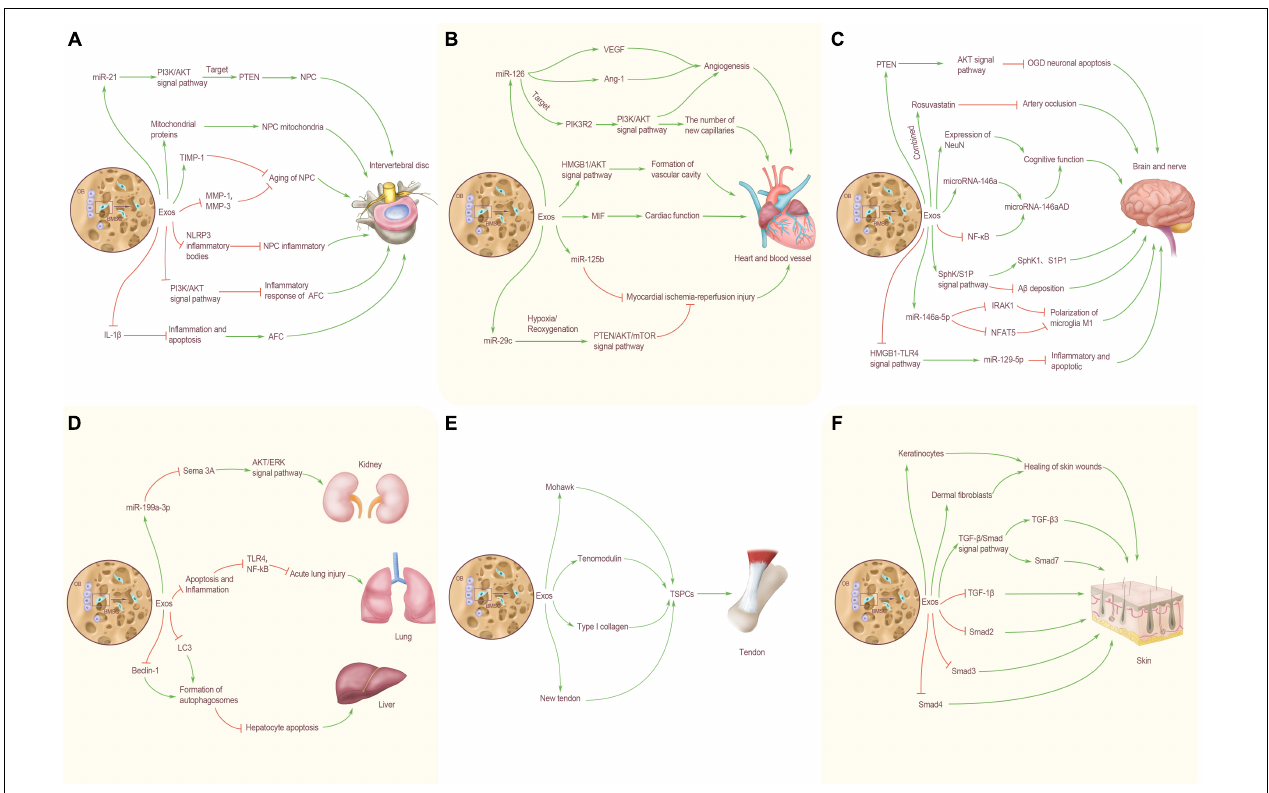
FIGURE 2 | BMSC-Exos transorgan regulation. (A) Effects of BMSC-Exos on intervertebral disc. MiR-21 in BMC-Exos inhibits NPC apoptosis by targeting PTEN through PI3K/AKT signaling pathway. BMC-Exos can provide NPC with mitochondrial proteins, and repair damaged mitochondria by supplementing